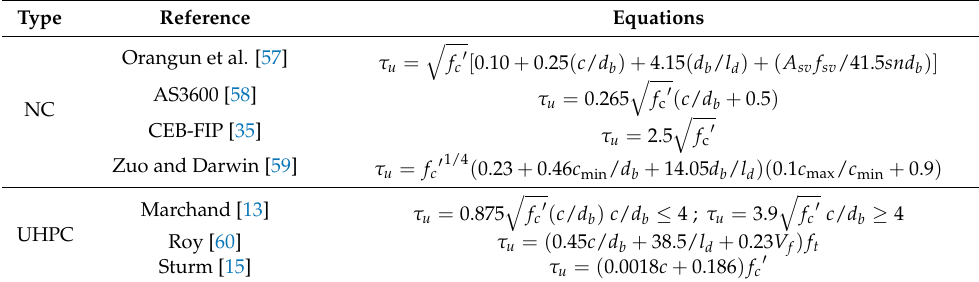
Table 7. Summary of typical bond strength equations (SI